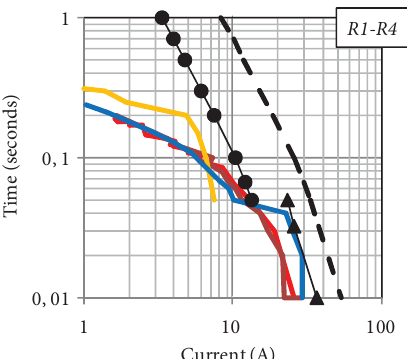
Figure 5: Results of the four relays of Figure 4 in the same graph. Te narrow lines with markers are two results of shifting the dashed line to the left. Te dashed line is the cumulative RMS value of test current.